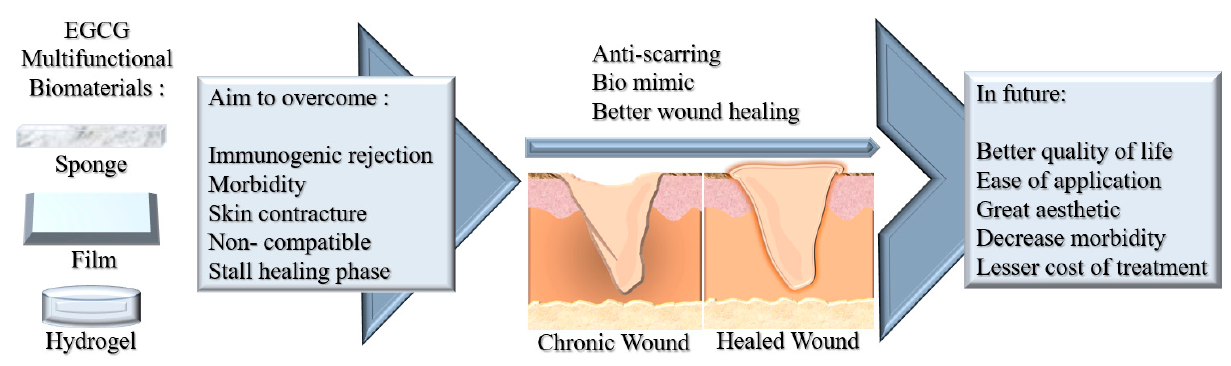
Figure 8. Schematic figure of the future perspectives on the development of EGCG multifunctional biomaterials.